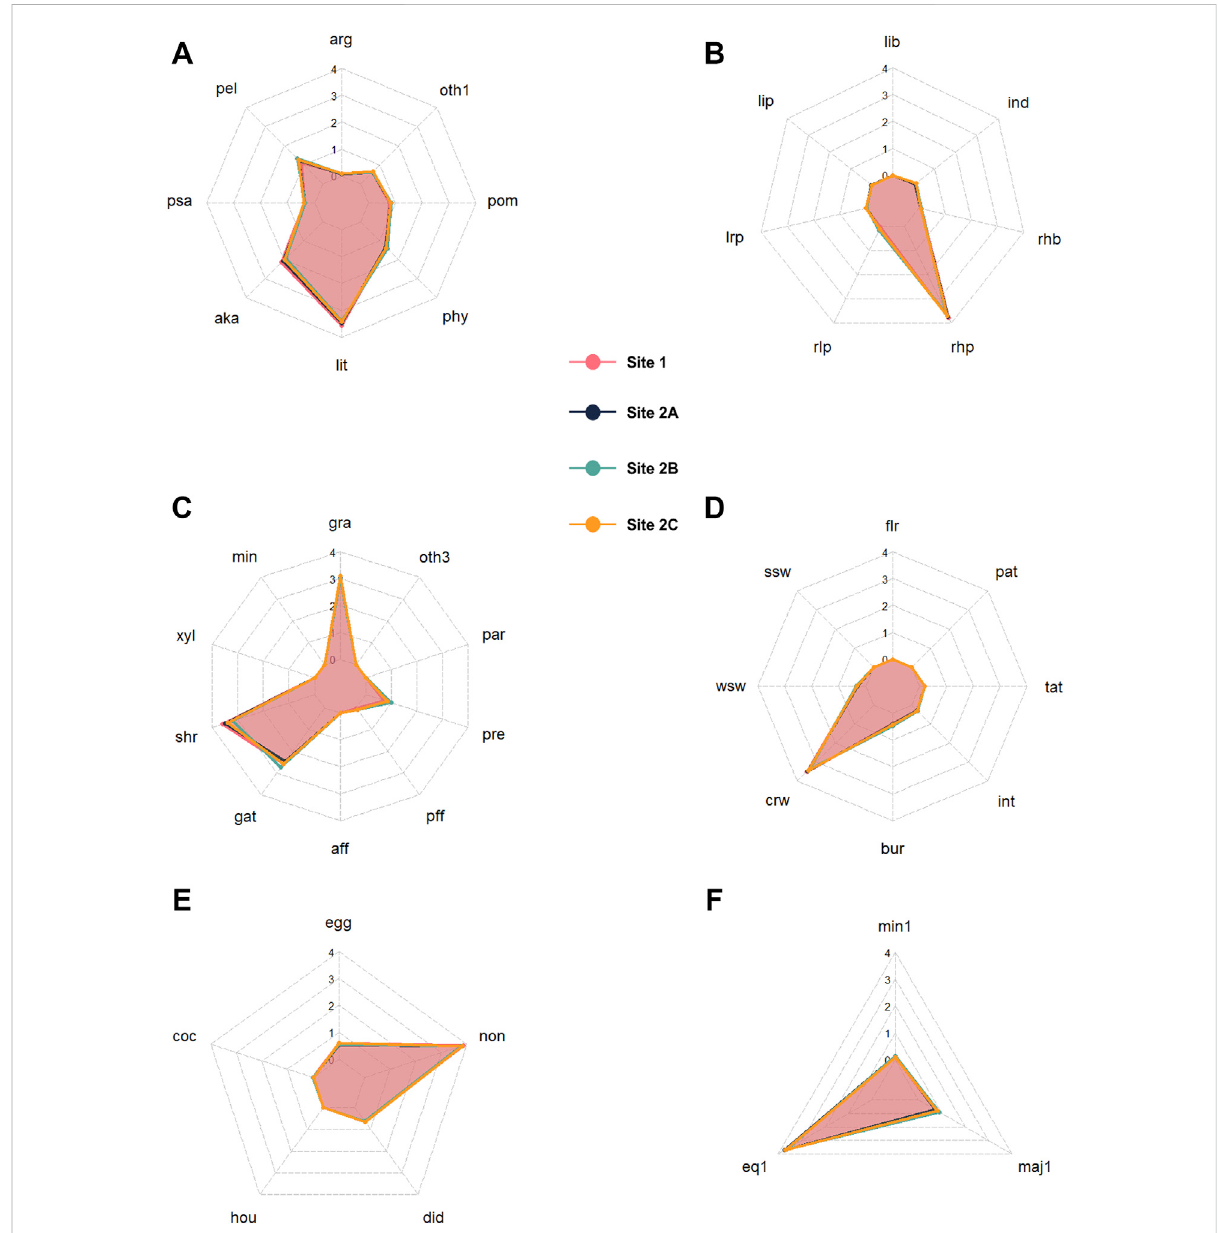
FIGURE 2 CWM values for each site and trait category, pictured as averages of the entire study period (5 years) for (A) microhabitat/substrate preference; (B) current preference; (C) feeding type; (D) locomotion and substrate relation; (E) resistance forms; and (F) potential number of cycles per year. Refer to Supplementary Table S1 for the abbreviations of trait categories and to Supplementary File S1 for the entire dataset of CWM